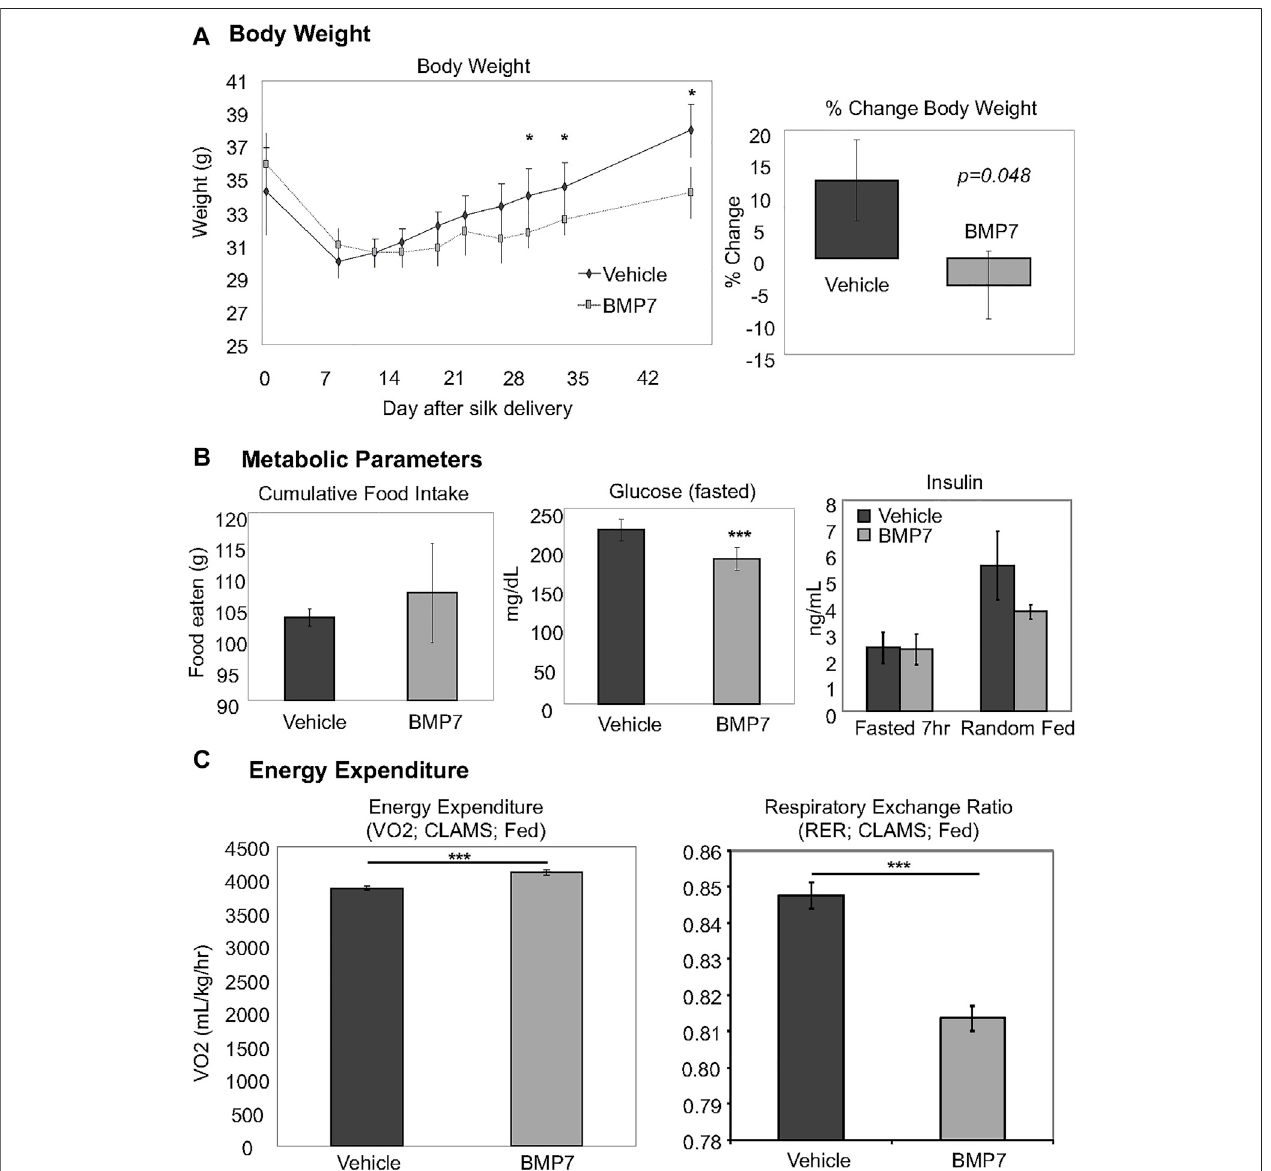
FIGURE 3 | Improved metabolism in obese mice treated with BMP7 hydrogels. (A) BMP7-treated mice fed a 45% high-fat diet for 3 months prior to hydrogel deliverylostmoreweightstartingat28 – 45 dayspost-injections.Forthesestudies,N=6-8micepergroupwereused. (B) BMP7-treatedmicedidnotchangefoodintake acrossthestudy(leftpanel),andshowedasigni fi cantreductioninfastedbloodglucoselevels(middlepanel)withnochangesinbloodinsulin(farrightpanel). (C) CLAMS data indicated an increase in VO2 and a decrease in RER in mice treated with BMP7 hydrogel. A reduction in RER from 1 to closer to 0.7 indicates a greater utilization of lipids as fuel, which would be expected with higher BAT